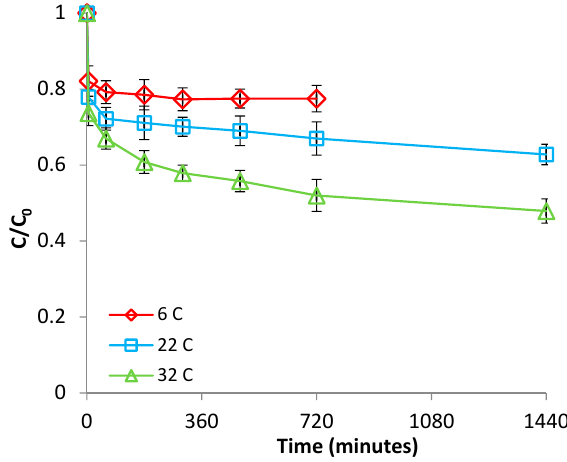
Figure 2. Effect of temperature on Fe(II) removal by bentonite.